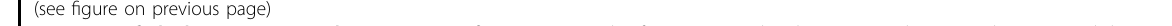
Fig. 6 GSK3 β depletion represses the expression of BRCA1. A Levels of DNA repair-related proteins in the parental HCT-15 and their GSK3 β -depleted single clone (KO1 and KO2) cells determined by western blotting. B Levels of DNA repair-related proteins in HCT-15 cells following treatment with 10 μ M CHIR99021 HCl (CHIR) or 5 μ M LY2090314 (LY) determined for 48 h by western blotting. C BRCA1 protein level was partially restored in HCT-15 GSK3 β -depleted cells transfected with full-length WT- GSK3 β cDNA (WT) but not with mutated -GSK3 β cDNA (Y216F). The relative intensities of the bands were quanti fi ed by Image J software and normalized to GAPDH levels. All data are expressed as mean ± SD from three independent experiments. (* p < 0.05, ** p < 0.01, *** p < 0.001, t test). D Exogenous expression of GSK3 β in HCT-15 cells increased BRCA1 protein level. The relative intensities of the bands were quanti fi ed by Image J software and normalized to GAPDH levels. All data are expressed as mean ± SD from three independent experiments. (* p < 0.05, t test). E mRNA expression of BRCA1 in the parental HCT-15 and their GSK3 β -depleted single clone (KO1 and KO2) cells was detected by qRT-PCR. ( n = 3, * p < 0.05, t test). F BRCA1 mRNA levels in HCT-15 cells treated with GSK3i, CHIR99021 HCl (CHIR), and LY2090314 (LY), for indicated times and concentrations. ( n = 3, * p < 0.05, ** p < 0.01, *** p < 0.001, one-way ANOVA). G and H The Snail and Slug expression levels were negatively correlated with the levels of BRCA1. The expression of indicated proteins was analyzed by western blotting in the HCT-15 cells transfected with the full-length Wnt3a cDNA ( G ), or treated with GSK3i LY2090314 (LY) and depleted GSK3 β (KO; H ). I Knockdown of Snail and Slug increased BRCA1 expression in HCT-15 cells. Cells were treated with siRNAs targeting human Snail, Slug, or siNC for 48 h. The expression of indicated proteins was analyzed by western blotting. J Silencing of Snail and Slug restored the levels of BRCA1 in GSK3 β KO cells. HCT- 15 and GSK3 β KO cells were treated with siSnail, siSlug, or siNC for 48 h. K and L Effect of single agent and combination treatment on indicated cells viability for combinations of PARP inhibitor, simmiparib (SP), plus GSK3 inhibitor LY2090314 (LY). UWB1.289 (carrying a BRCA1 mutation) and UWB1.289 + BRCA1 (restored with wild-type BRCA1) cells were analyzed 7 days after treatment with simmiparib (SP), LY2090314 (LY), or a combination ( K ). HCT-15 and RKO cells were transfected with siBRCA or siNC for 24 h and then followed by treatment of simmiparib (SP), LY2090314 (LY), or a combination for 7 days ( L ). Cell viability was measured by SRB assay. Combination index (CI) was calculated using CompuSyn software with the Chou – Talalay equation, and average CI values are presented (CI < 1, synergism; CI = 1, additive effect; CI > 1 antagonism). Data are from three independent experiments and expressed as mean ±